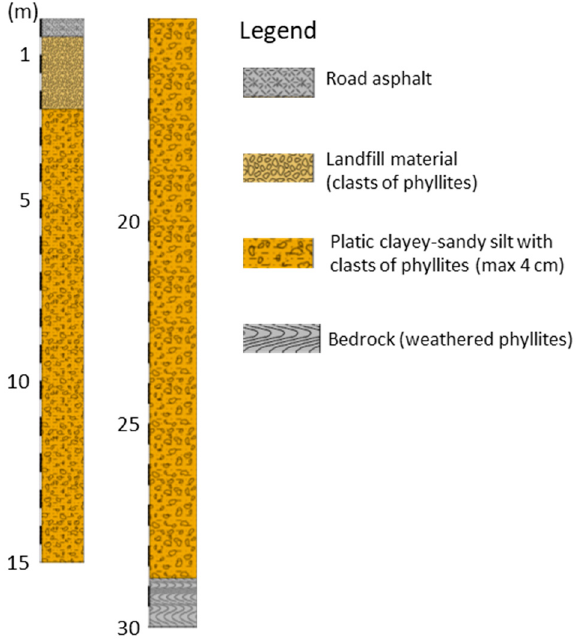
Figure 4. Stratigraphy of the landslide of Pariana deduced by the borehole.